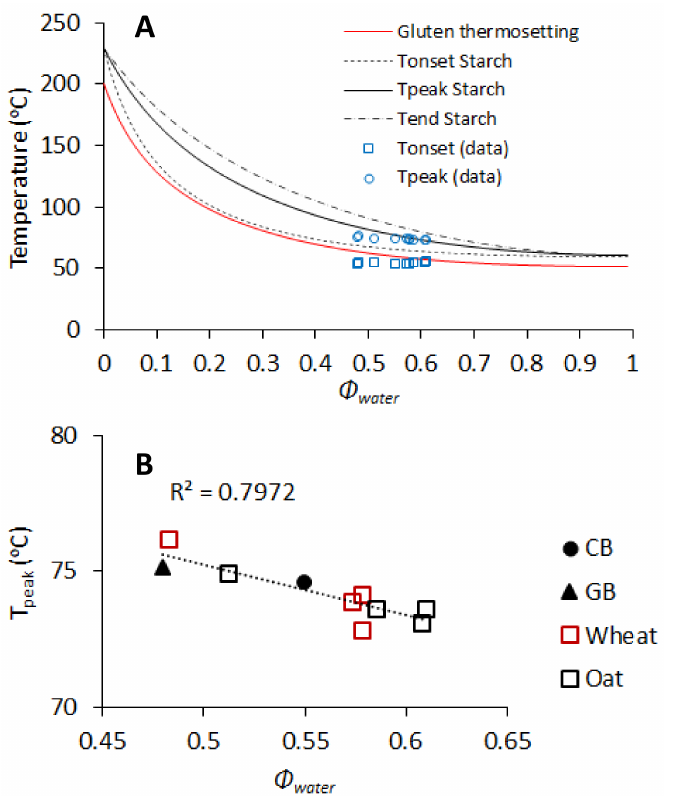
Figure 4. T onset and T peak as determined for the different dough samples from DMTA plotted in the supplemented state diagram for dough baking with phase transitions for gluten and starch ( A ). The state diagram is adapted from [13,14]. Correlation between T peak and the volume fraction of water Φ water in each dough ( B ). CB = control dough and GB = dough with glass